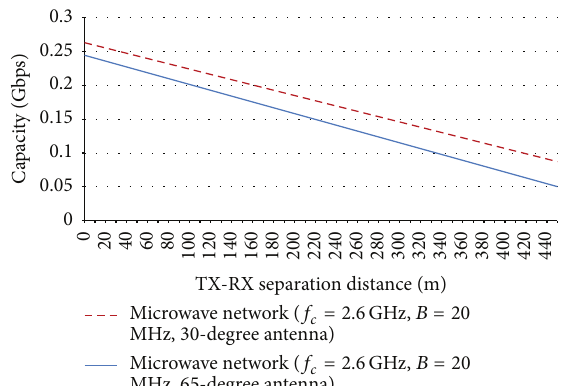
Figure 5: Capacity trend in Gbps for 2.6 GHz microwave networks using 65 ∘ and 30 ∘ transmitting antenna beamwidths.